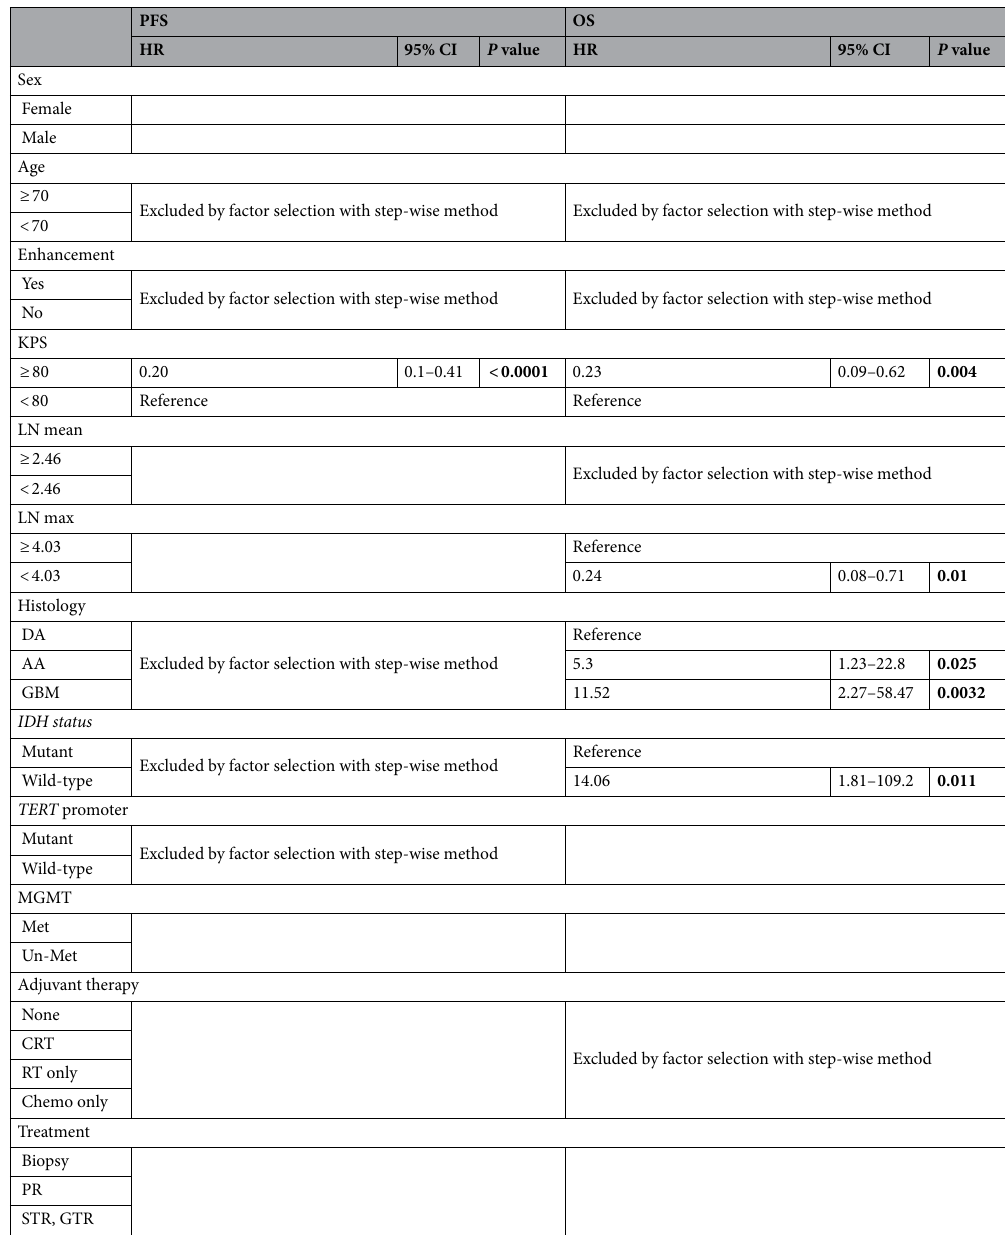
free survival, HR hazard ratio, CI confidence interval, OS overall survival. P values in bold font are statistically